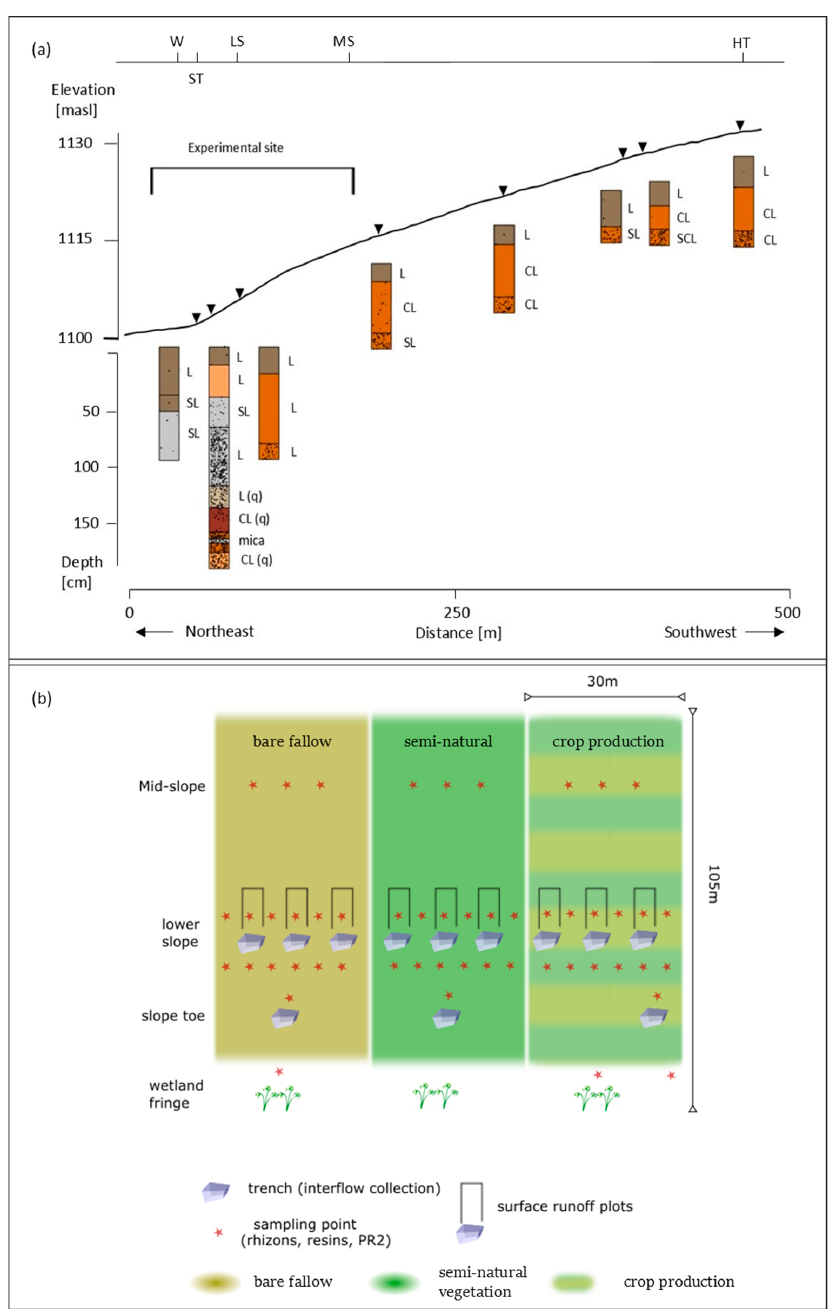
Figure 2. ( a ) Position of the study area along the hill slope transect (W = wetland, ST = slope toe, LS = lower slope, MS = mid-slope, HT = hilltop) and soil profiles along the catena stretching from the wetland fringe to the hilltop (CL = clay loam, L = loam, SL = sandy loam, SCL = sandy clay loam) ((q) indicates that texture was manually determined in the field and not via laser diffraction in the laboratory). The colors are chosen according to qualitative observations in the field. Triangles mark the position of soil sampling points along the catena. ( b ) Overview of the experimental setup.